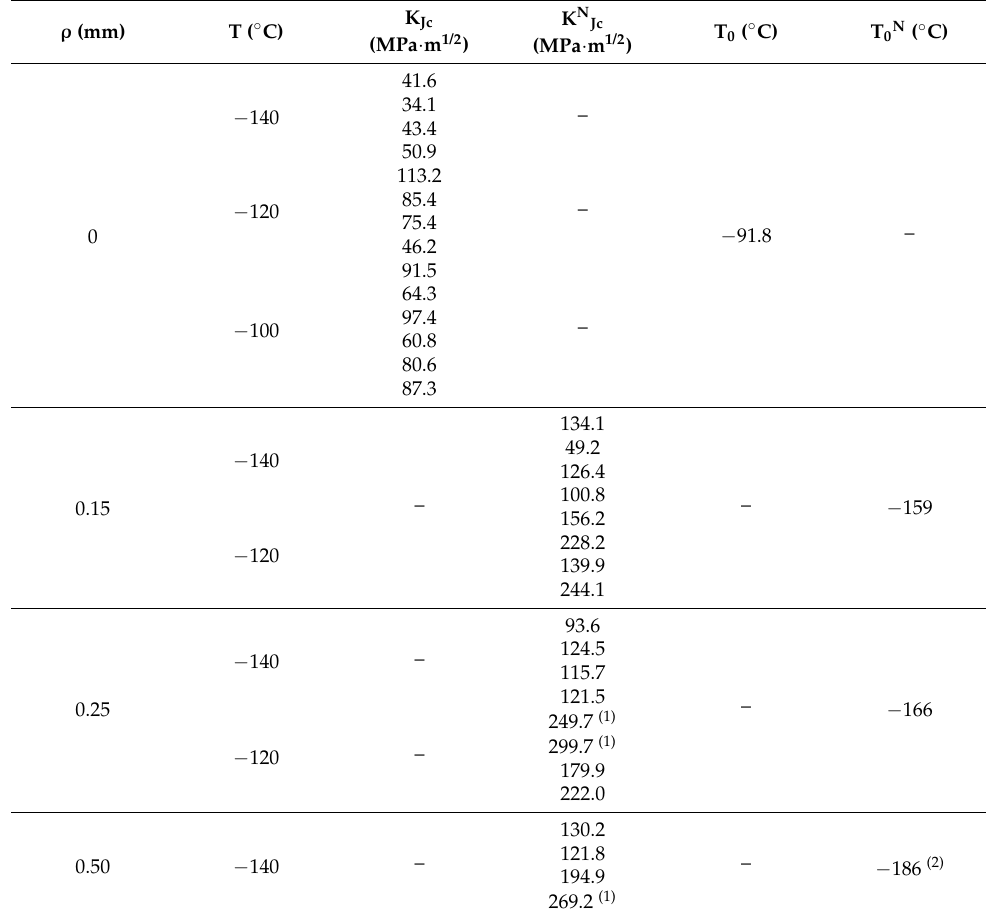
Table A3. Fracture toughness (K Jc ) and apparent fracture toughness (K N Jc ) results in steel S460M, together with reference temperature results. 0.6T (15 mm thick) SENB specimens. Results converted to 1T equivalent [14].